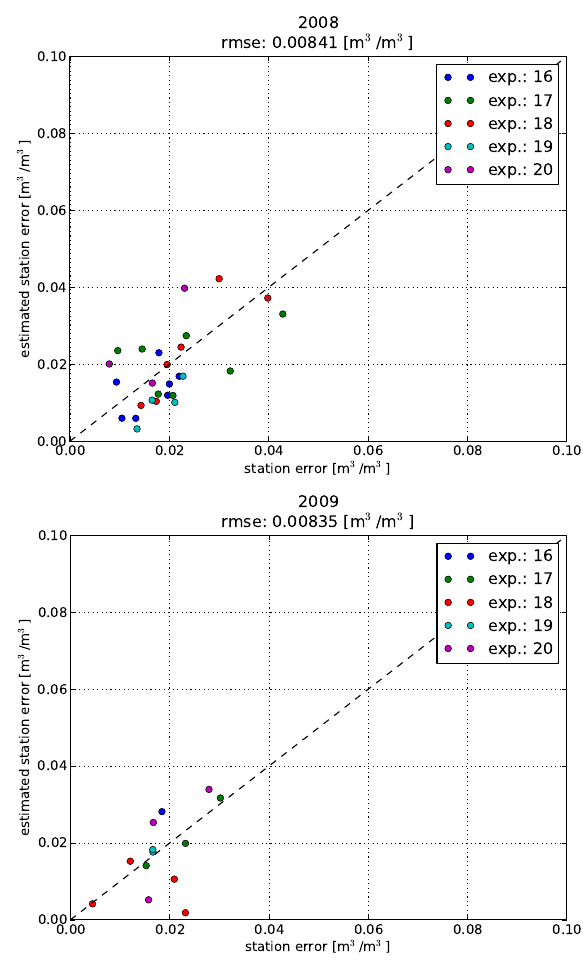
Fig. 9. Comparison of the estimated station error ( e stat ) with the reference soil moisture error ( e station ) for the years 2008 and 2009 using periods with significant correlations between all soil moisture data sets. Different colors correspond to different